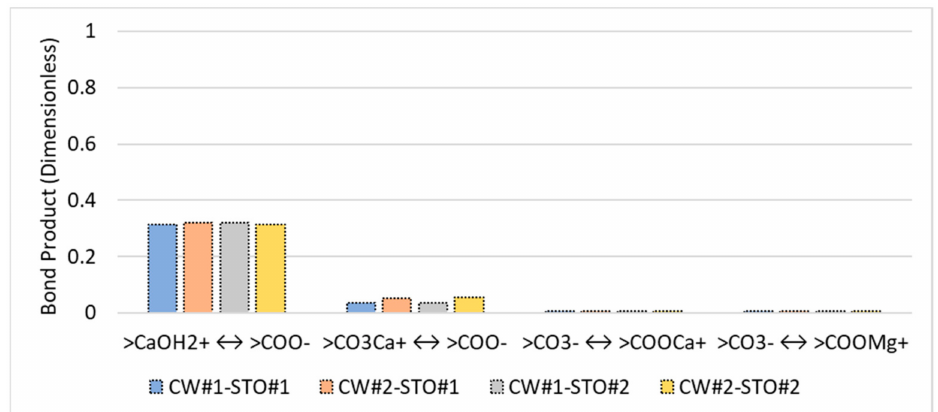
Figure 4. Bond product (oil adhesion mechanism) of calcite during FWI.